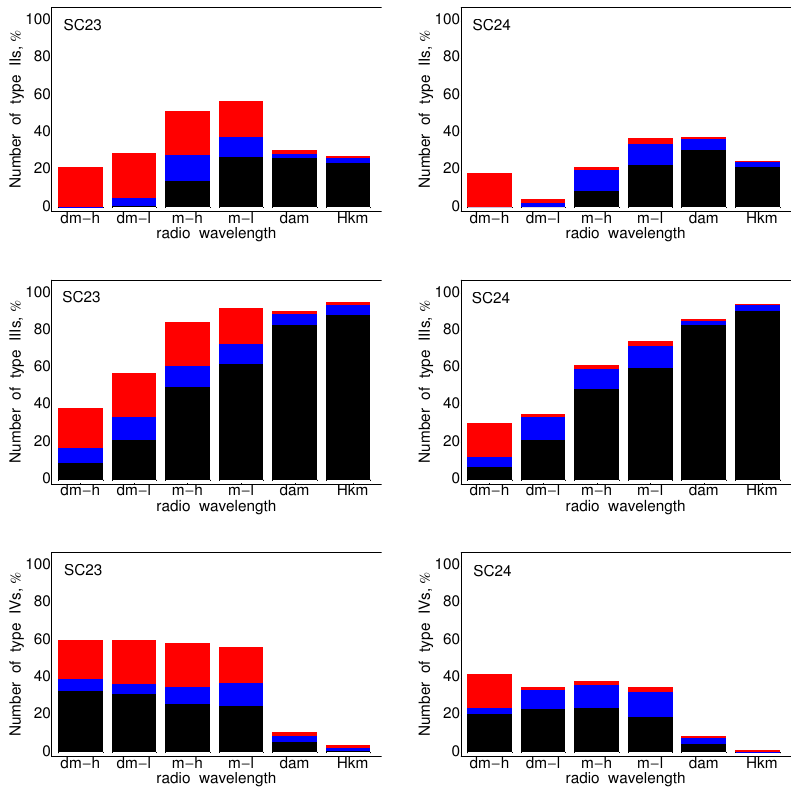
Figure 2. Plots of type II ( top ), III ( middle ) and IV ( bottom ) radio bursts, normalized to 547 SC23 ( left ) and 285 SC24 (on the right ) SEE events. Color code as in Figure